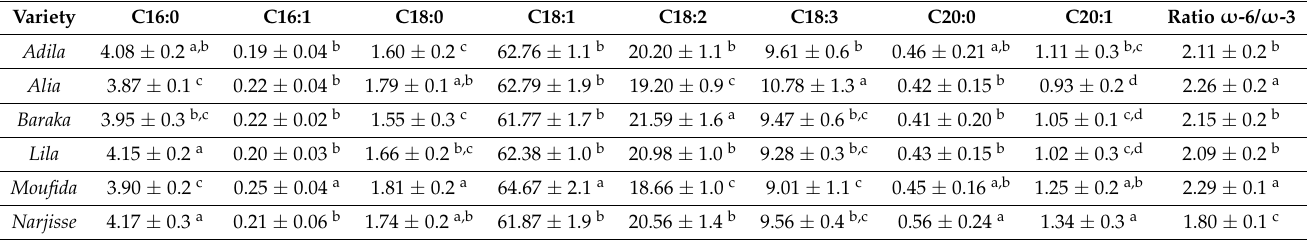
Table 5. Fatty acid composition (% of total fatty acids) in seed oil of six Moroccan rapeseed varieties evaluated in two contrasting